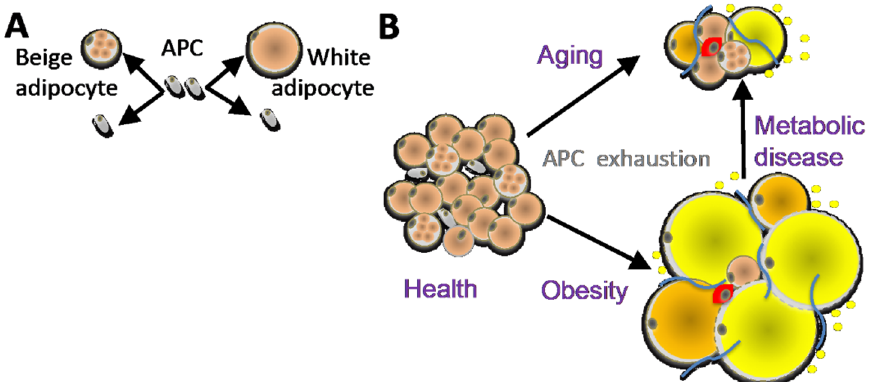
Figure 1. ( A ) Distinct adipose progenitor cell (APC) lineages maintain pools of white and beige adipocytes. ( B ) In aging and obesity, APC senescence results in adipocyte, hypertrophy, hypoxia and death, causing leukocyte infiltration (red), inflammation, fibrosis (blue), and lipid incontinence (yellow).